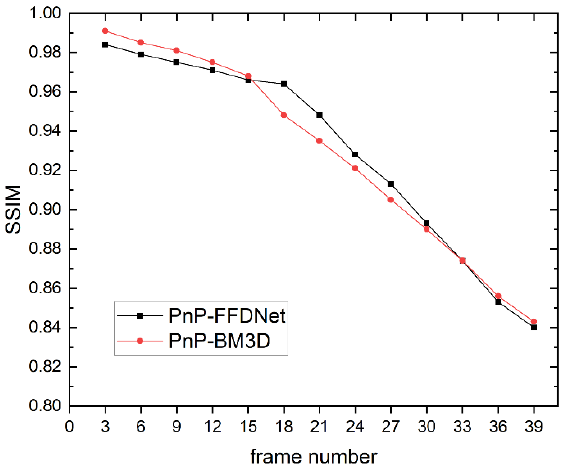
Figure 9. Line chart of PSNR of the reconstruction results of PnP-FFDNet and PnP-BM3D when the number of CUP compressed frames increases.